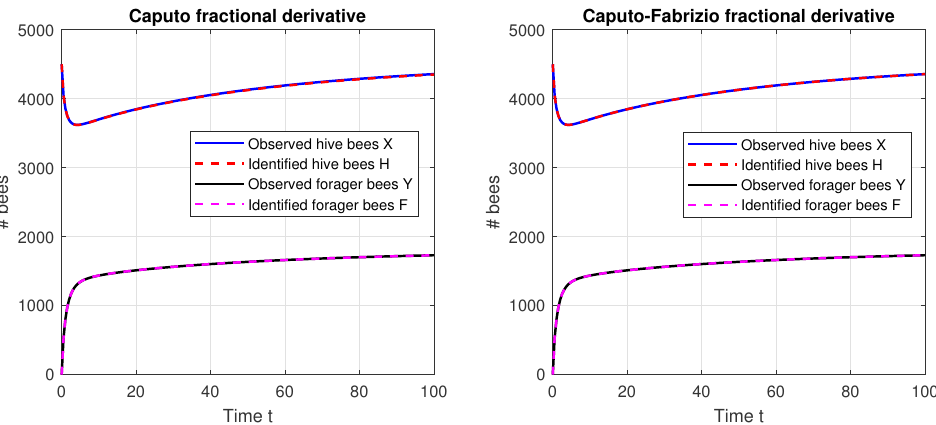
Figure 5. The implied population dynamics with r = 0.9 and q = 0.95, modeled by the Caputo (3a)–(3c) ( left ) and Caputo–Fabrizio derivatives (4) ( right